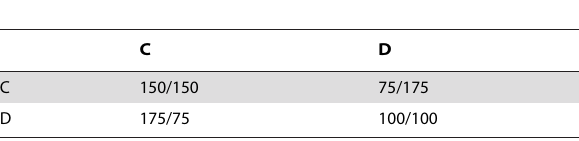
Table 1. The public goods